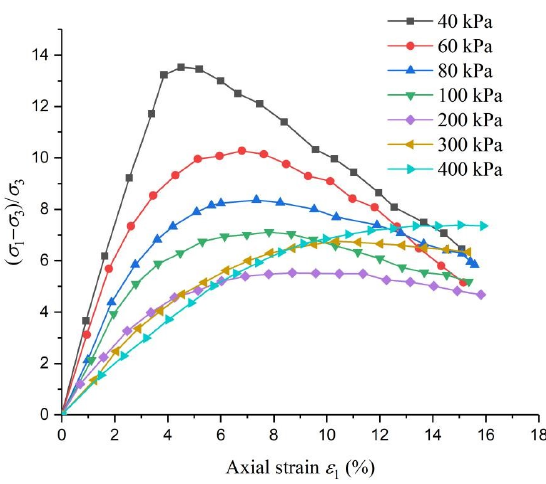
Figure 8. Calcareous sand samples after the test.